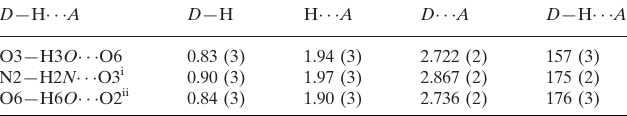
Hydrogen-bond geometry (A˚ , (cid:3)